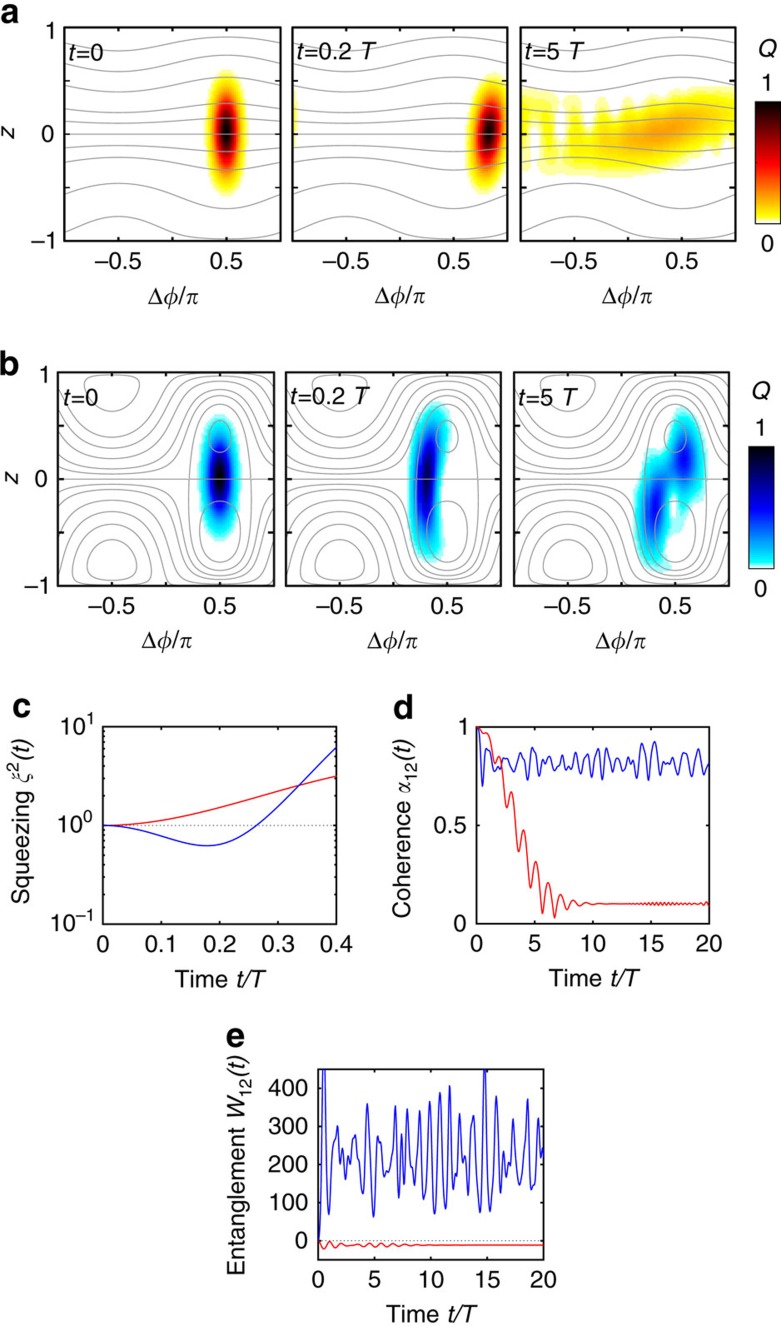
From short-term quantum squeezing to long-term phase coherence and number entanglement.Quantum dynamics of two coupled oscillators or modes; the initial state being a two-mode coherent state |z, Δφ〉=|0, π/2〉. (a) For sufficiently small coupling strengths (here K=0.1ω) the two modes simply dephase. The Husimi density Q(z, Δφ; t)≡|〈z, Δφ|Ψ(t)〉|2 (ref. 43) spreads out along the phase direction. (b) Squeezing and number entanglement emerge for a sufficiently large coupling strength (here K=0.8ω). At intermediate times, the Husimi density is Q(z, Δφ; t) is compressed in the phase direction. For long times, the quantum state is trapped in the right half of phase space implying preservation of phase coherence. The grey lines in (a,b) show trajectories of the classical mean-field system (2) bearing the Kuramoto model. (c–e) Evolution of (c), the squeezing parameter ξ2 (refs 13, 19), (d) the phase coherence α12 and (e) the number entanglement W12 for K=0.8ω (blue line) and K=0.1ω (red line). Short-term quantum squeezing, long-term phase coherence, and number entanglement are observed for a strong coupling K=0.8ω. Parameters for all panels are N=40, U=0.4/N, T=2π/ω and . The initial state is a two-mode coherent state |z, Δφ〉=|0, π/2〉.